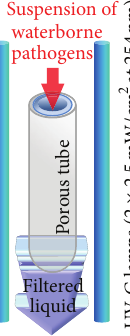
Figure 2: Schematic illustration of a handy water purification unit consisted of the porous tube and a pair of UV-C